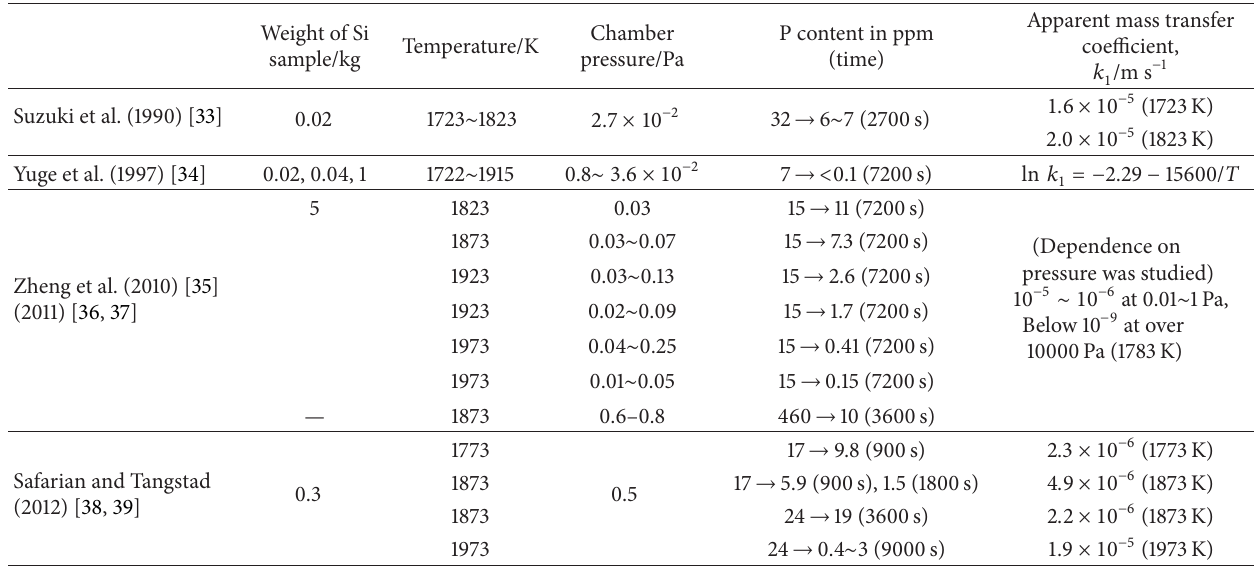
Table 3: Previous research on removal of P by induction